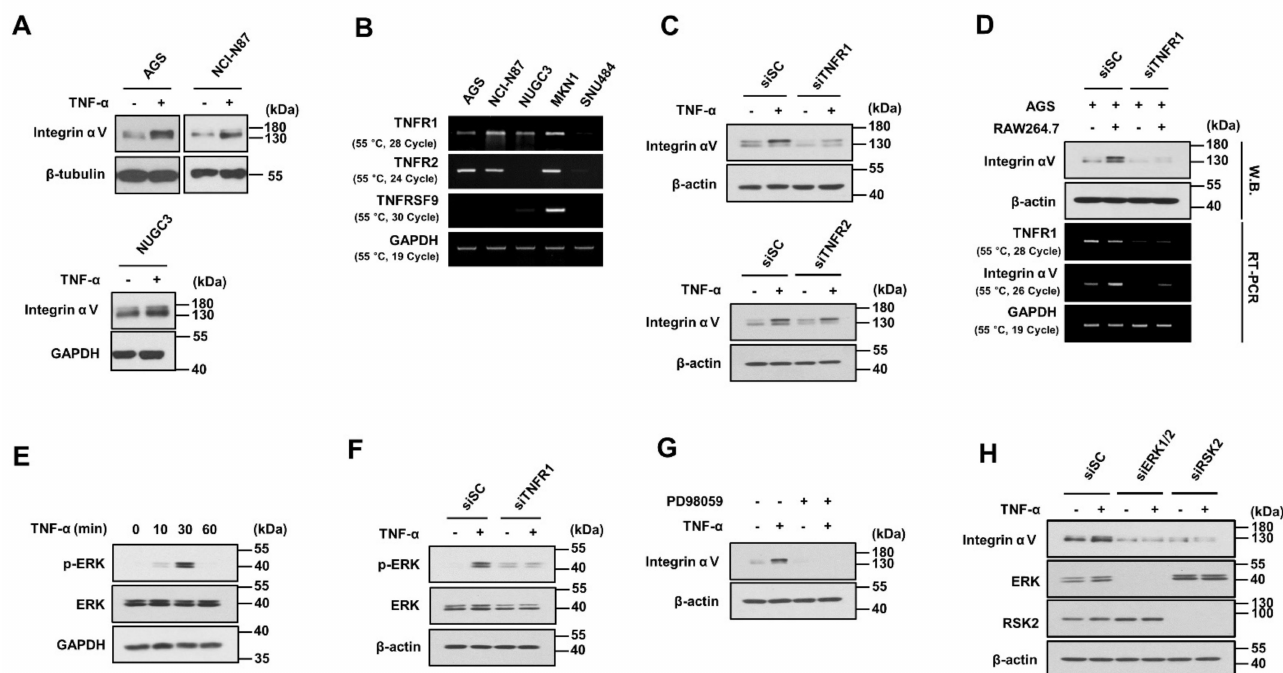
Figure 3. Increased integrin α V in gastric cancer cells through TNF − α /TNFR1/ERK signaling. ( A ) Increased integrin α V expression is induced by TNF − α in gastric cancer cell lines. Cells were treated with 20 ng/mL TNF − α for 24 h. Integrin α V expression was analyzed by Western blotting (three replicates). ( B ) The expression of TNFRSF9, TNFR1, and TNFR2 in gastric cancer cell lines. TNFRSF9, TNFR1, and TNFR2 expression was analyzed by RT − PCR (two replicates). ( C ) The effect of TNFR1 and TNFR2 knockdown on TNF − α − induced expression of integrin α V. AGS cells were transfected with 40 nM siScrambled or siRNA targeting TNFR1 or TNFR2 for 24 h and then treated with TNF − α for 24 h (three replicates). ( D ) The effect of TNFR1 on the expression of integrin α V increased by the coculture of AGS cells with RAW264.7 cells. The mRNA and protein expression of integrin α V was analyzed by Western blotting (three replicates) or RT − PCR (four replicates). ( E ) Increased phosphorylation of ERK by TNF − α . AGS cells were incubated with serum − free medium for 24 h and then treated with TNF − α at the indicated times. Phospho − ERK and ERK expression was analyzed by Western blotting (three replicates). ( F ) The effect of TNFR1 on the TNF − α − induced phosphorylation of ERK. AGS cells transfected with siScramble or siTNFR1 were treated with TNF − α for 30 min (four replicates). ( G ) The effect of ERK on TNF − α − induced integrin α V expression. After pretreatment with PD98059 for 1 h, AGS cells were treated with TNF − α for 24 h (three replicates). ( H ) The effect of ERK and RSK2 on the TNF − α − induced expression of integrin α V. AGS cells were transfected with siScramble, siERK1/2, or siRSK2 for 24 h and then the cells were treated with TNF − α for 24 h. The protein expression was analyzed by Western blotting (four